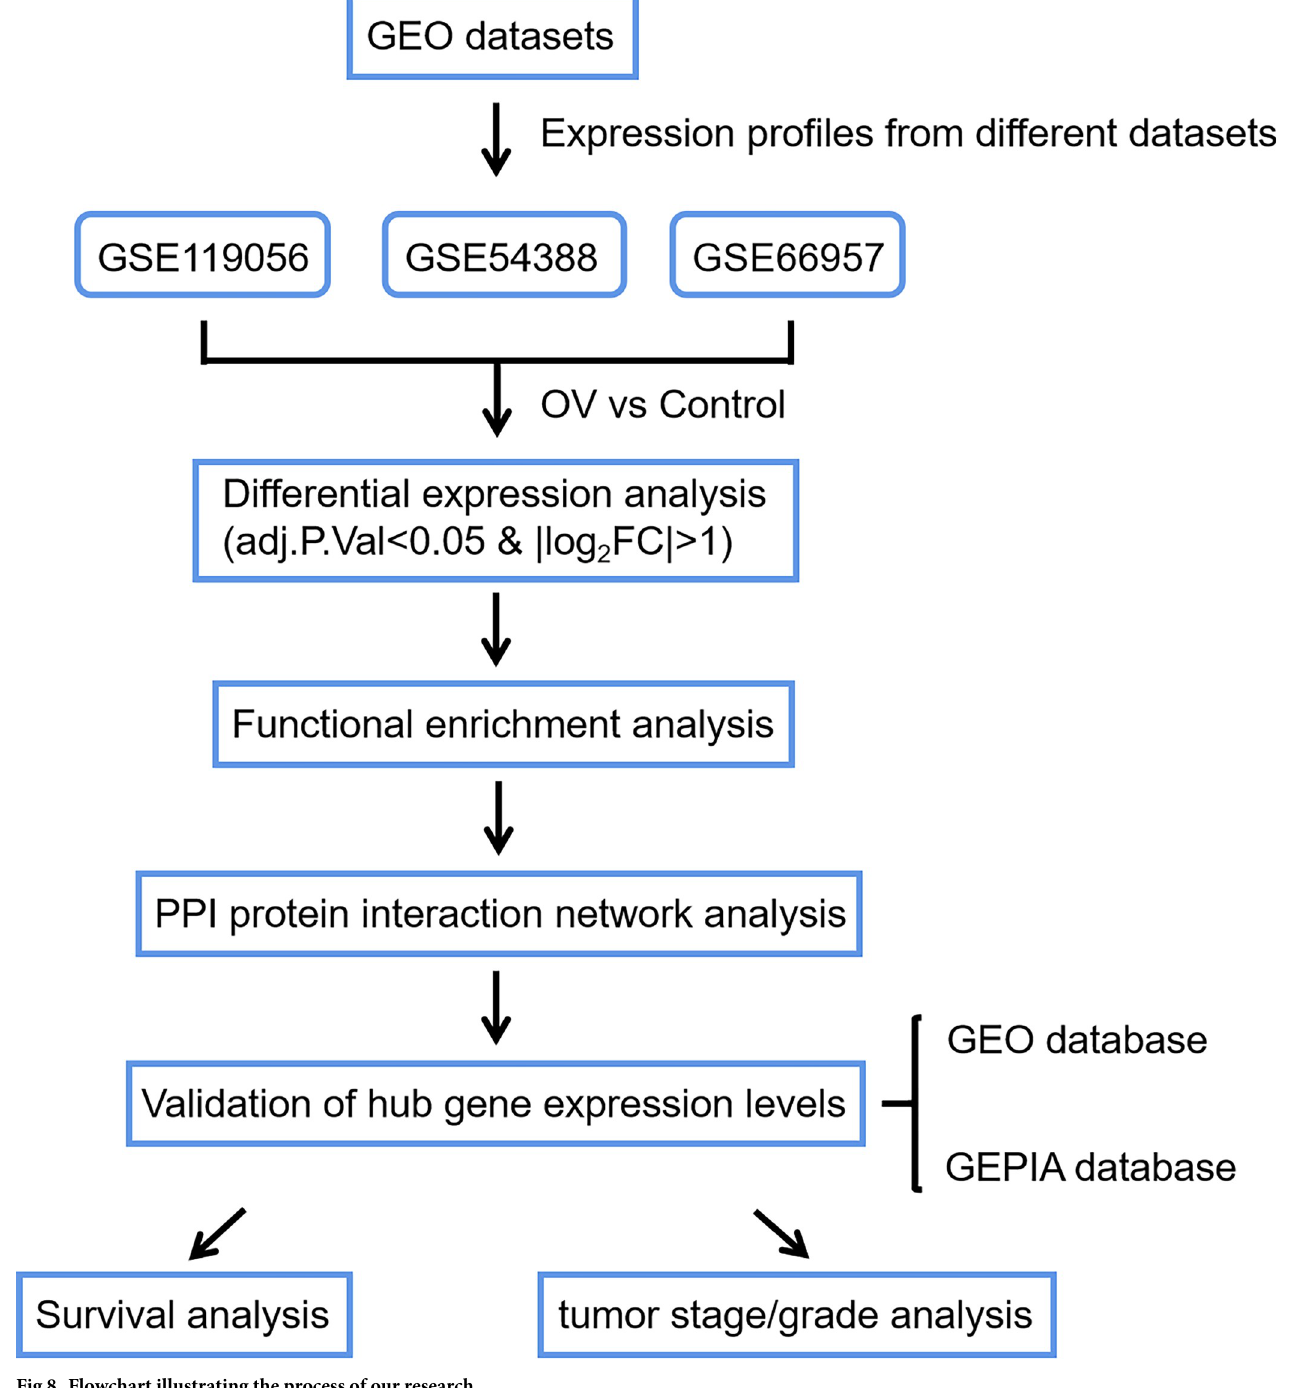
Fig 8. Flowchart illustrating the process of our